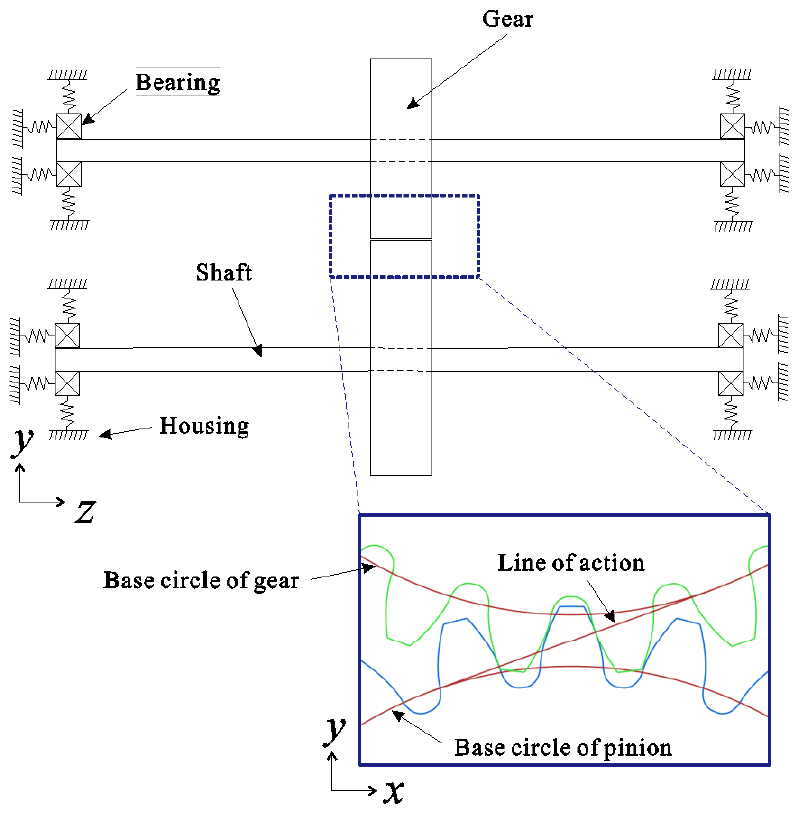
Figure 3. Schematic of gearbox with transverse line of action between the meshed gears.